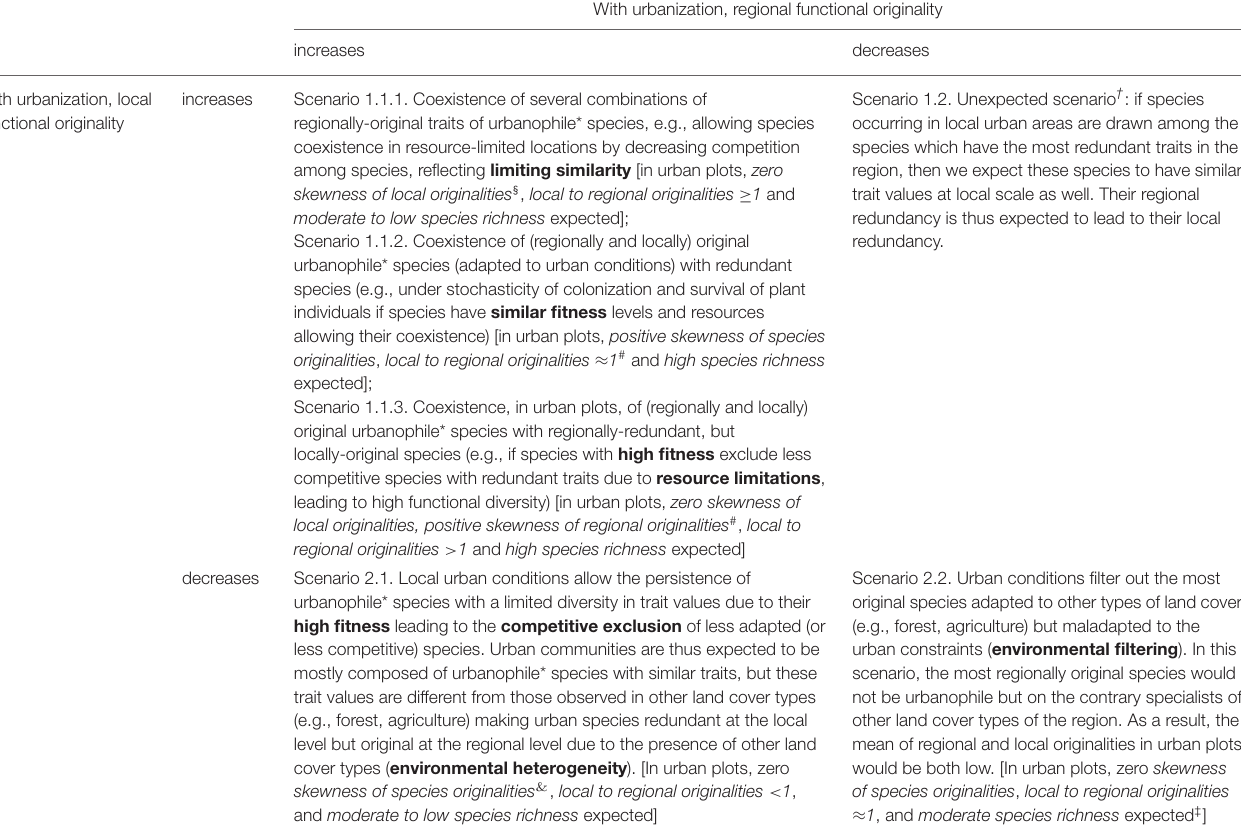
TABLE 1 | Scenarios which could explain each combination of patterns between (mean) local and regional functional originality of the same species along the urbanization